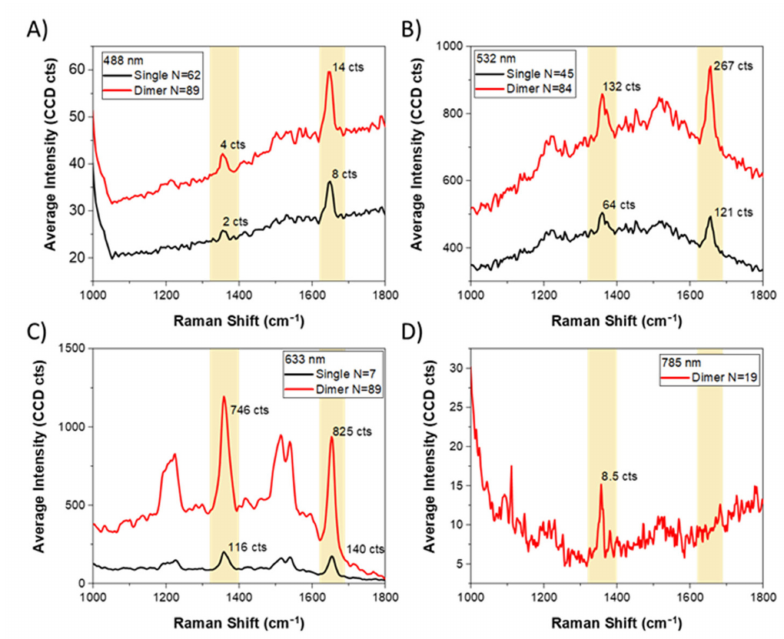
Figure 3. Averaged SERS spectra of self-assembled dimers or single nanoparticles composed of 60 nm AuNP modified with TAMRA. In the insets, the number of spectra that were obtained and averaged is given. The exciting wavelengths used were ( A ) 488 nm, ( B ) 532 nm, ( C ) 633 nm and ( D ) 785 nm. In all Raman experiments, the laser power was kept at 300 µ W and the integration time was 2 s.